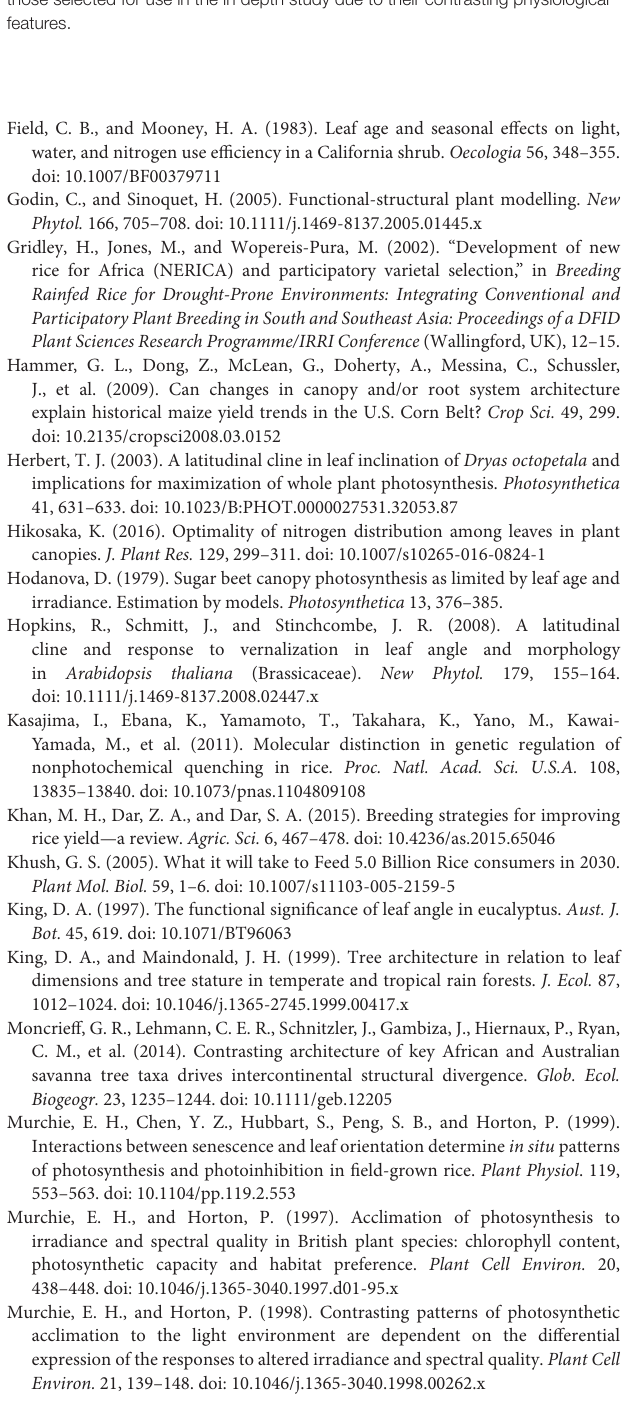
Supplementary Figure S2 | Correlations for different parameters for the two growth stages. Supplementary Table S1 | Agronomic details on the 16 Parental Lines used to develop the indica and japonica MAGIC Populations. Data for MAGIC